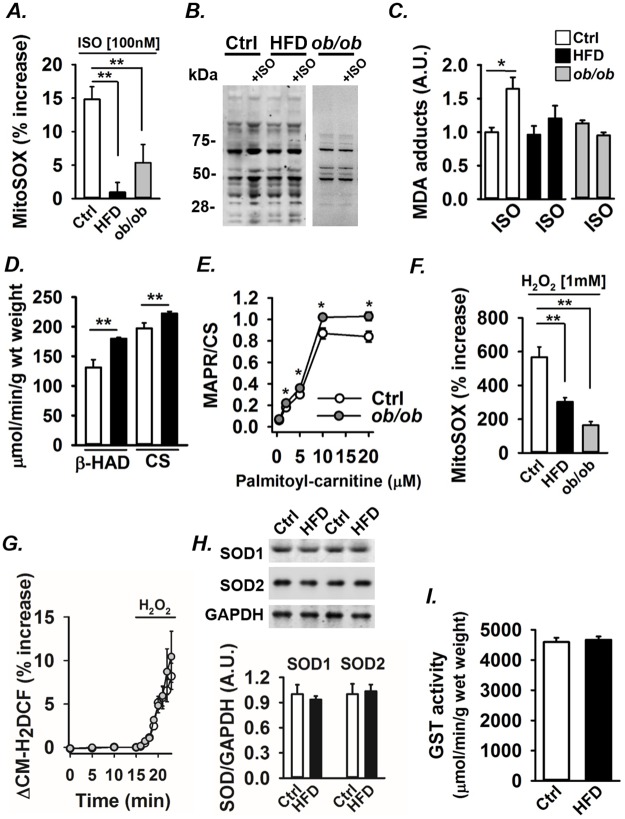
β-adrenergic stimulation increases mitochondrial ROS production in WT but not in metabolic syndrome hearts.(A) Mean data of mitochondrial ROS production in response to ISO (100 nM) measured with MitoSOX Red in WT (n = 29), HFD (n = 19) and ob/ob (n = 25) cardiomyocytes. Representative Western blots (B) and mean data (C) of MDA protein adducts in control, HFD and ob/ob hearts with or without ISO perfusion (100 nM) as indicated (n = 4–6 in each group; data in each group normalized to mean value in control cardiomyocytes without ISO, which was set to 1.0). (D) β-HAD and CS activity in left ventricles from control and HFD hearts (n = 6). (E) Mitochondrial ATP-production rate (MAPR) in isolated mitochondria determined in the presence of 0.5–20 μM palmitoyl-carnitine presented as the ATP synthesis rate is given per of CS activity (MAPR/CS; n = 6). (F) Mean data of mitochondrial ROS during application of H2O2 (1 mM) measured with MitoSOX Red in control (n = 45), HFD (n = 21) and ob/ob (n = 26) cardiomyocytes. (G) Mean data of cytosolic ROS, measured with the general ROS indicator CM-H2DCFDA, during exposure to H2O2 (1 mM) in control (n = 19) and ob/ob (n = 21) cardiomyocytes. Representative Western blots of SOD1 and SOD2 protein expression and mean data (H) in control and HFD left ventricles. (I) Mean data of the total GST activity in left ventricles from control and HFD hearts. Data are presented as mean ± SEM; *P < 0.05, **P < 0.01 vs. control (A and D-F); *P < 0.05 vs. without ISO (C).